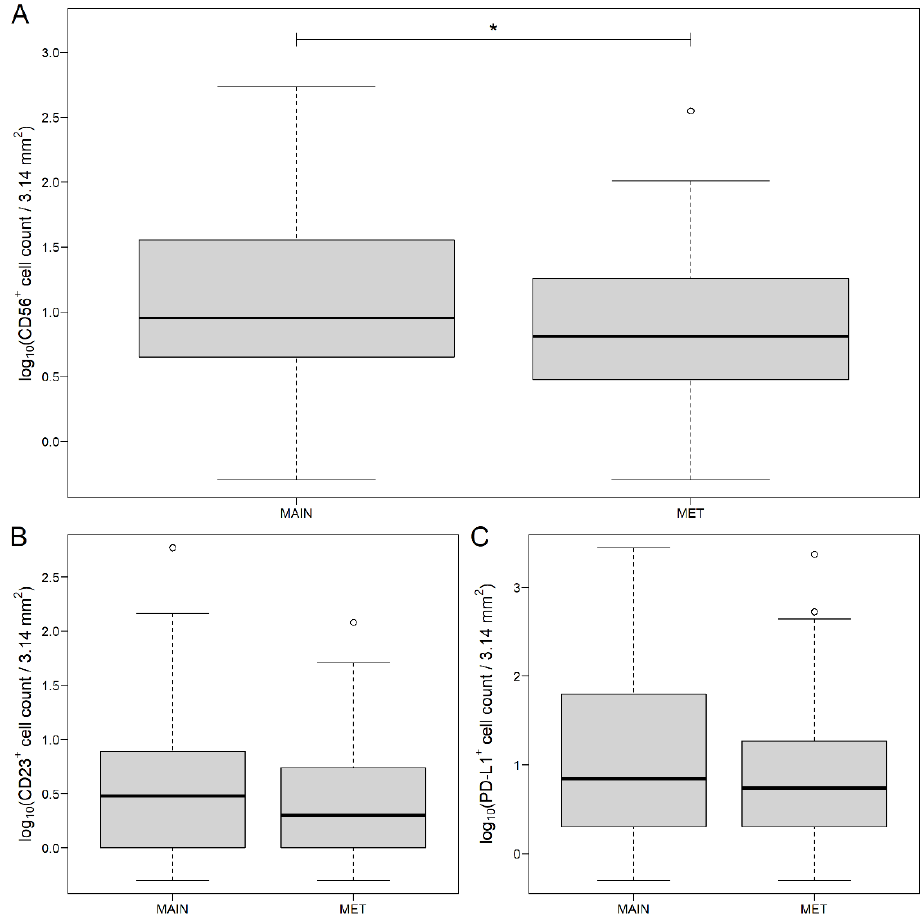
Figure 1. CD56 ( A ), CD23 ( B ) and programmed death-ligand 1 (PD-L1, ( C )) count data of main tumor mass (MAIN) and liver metastasis (MET) samples of colorectal cancer patients. While CD56 was significantly different between the two sample types, only marginal differences were justified in the case of CD23 and PD-L1. The hollow black circles and the thick line represent outliers (>1.5 times the interquartile range above the upper quartile) and the median value, respectively. * p < 0.05.